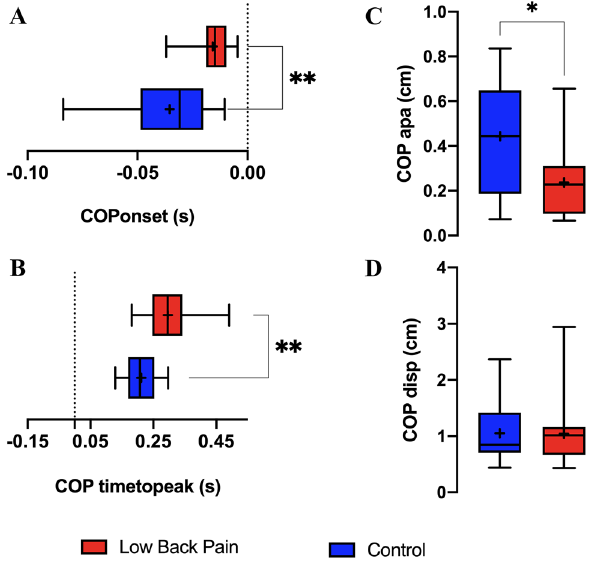
Figure 7. ( A ) COP onset; ( B ) COP timetopeak; ( C ) COP APA , and ( D ) COP disp . Differences were significant when p < 0.05 (*). Data expressed by central line = median, box = 25 and 75 percentiles, and whiskers = min and max values (mean values inside box marked as